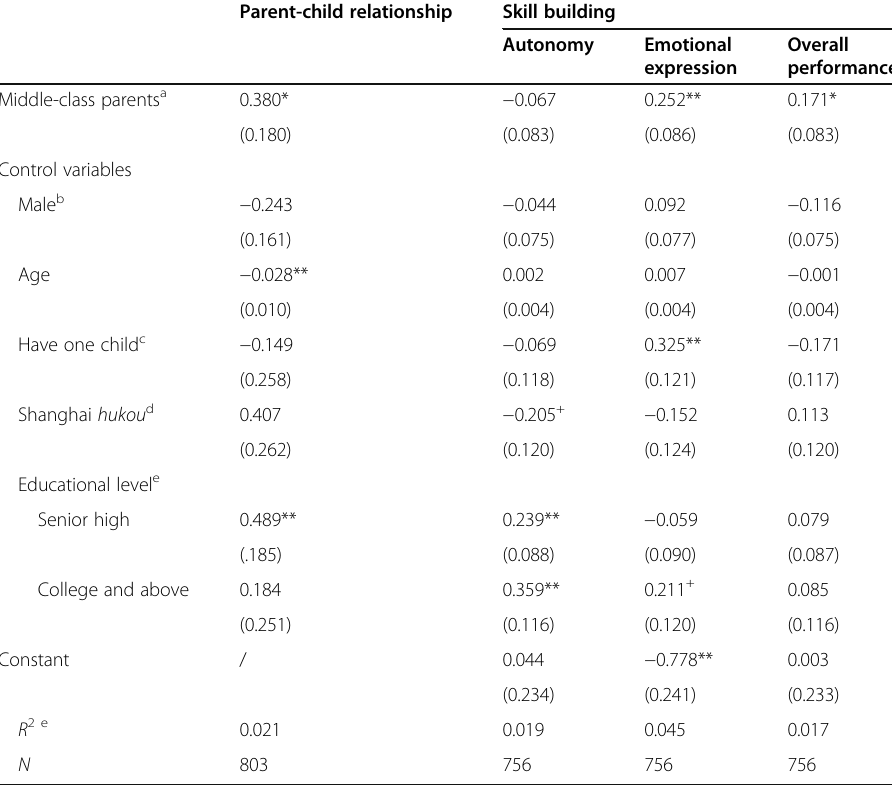
Table 4 Ordinal logistic regressions on the parent-child relationship and multivariate linear regressions on skill building in SHFS